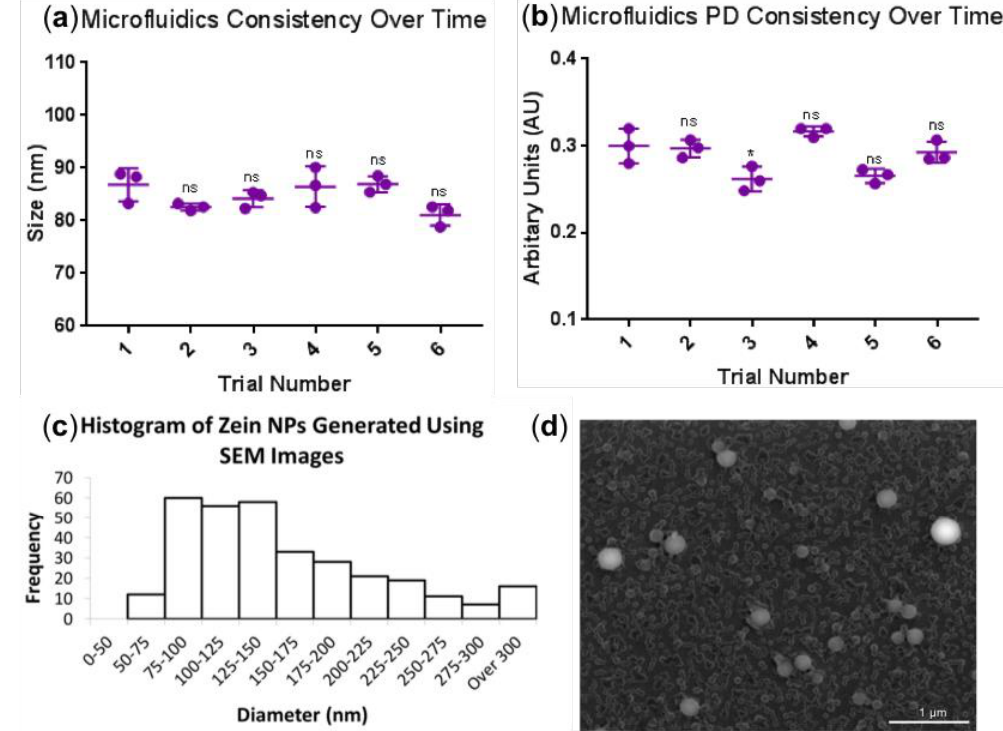
Figure 6. Reproducibility of Zein nanoparticles (NPs) made using a microfluidics system as demonstrated by: ( a ) the diameter of Zein NPs produced with the same parameters using different stocks on different days; ( b ) the polydispersity (PD) of Zein NPs produced with the same parameters using different stocks on different days; ( c ) a histogram of a Zein NP sample generated using scanning electron microscopy (SEM) images that was determined to be 113 nm using dynamic light scattering (DLS); ( d ) a representative SEM image of the 113 nm sample obtained.